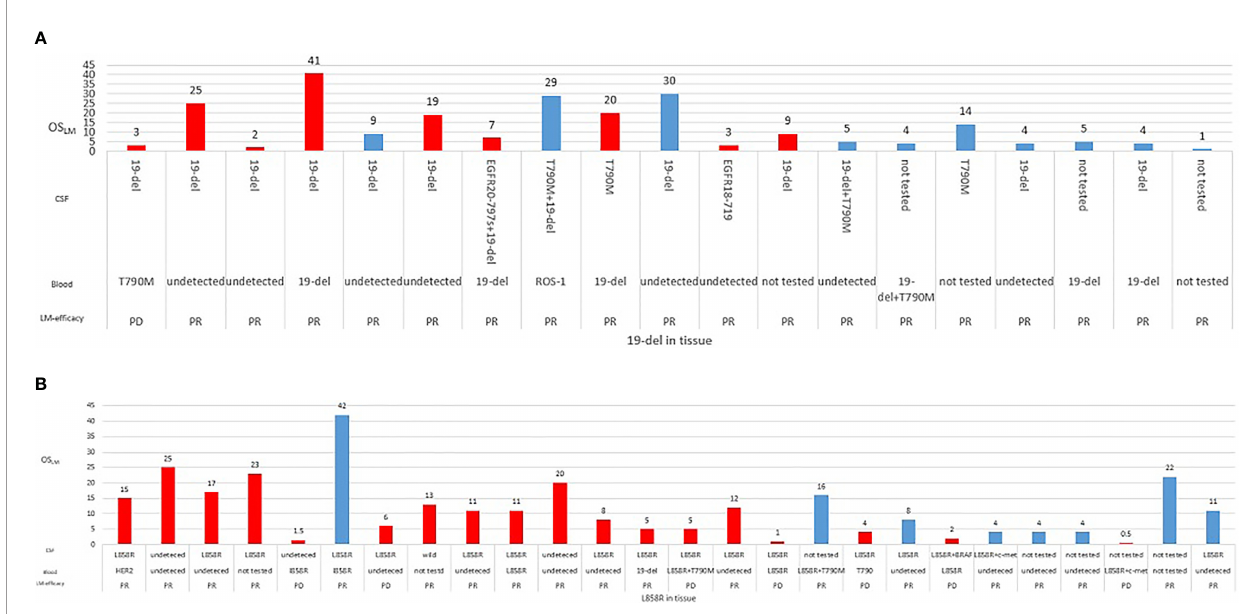
FIGURE 5 | Overall survival of each patient according to EGFR mutation status for (A) exon 19 deletion (19del) (n = 26) or (B) L858R (n = 26) detected from tissue samples. Information for best objective response from treatment received after developing leptomeningeal metastasis (LM), EGFR mutations detected from cerebrospinal fl uid (CSF), and plasma samples were also